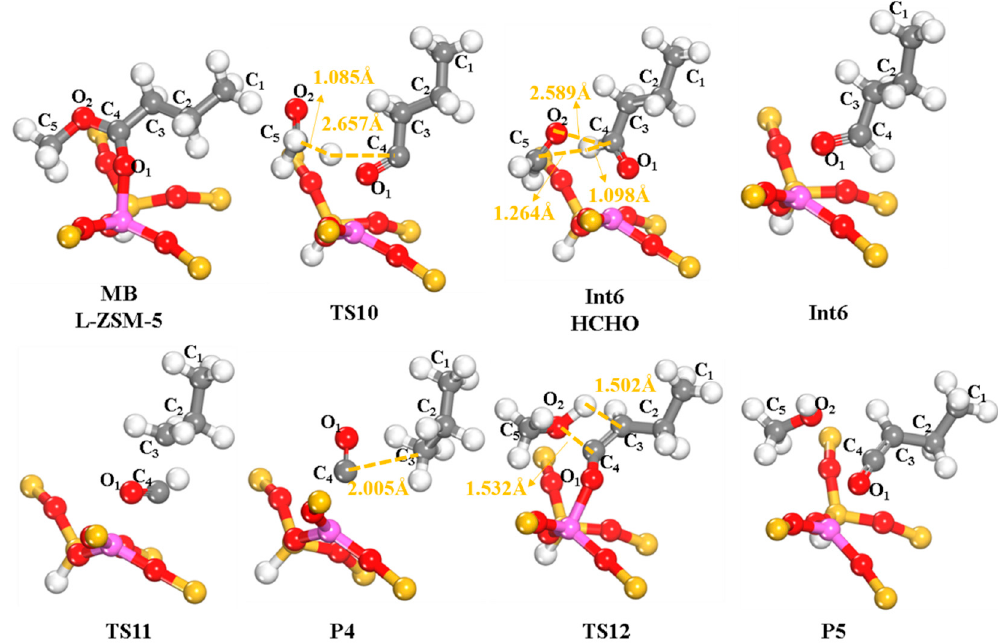
Figure 5. The structures of initial, transition, and final states for the α -C–O bond cleavage of MB on 32 T cluster of ZSM-5.